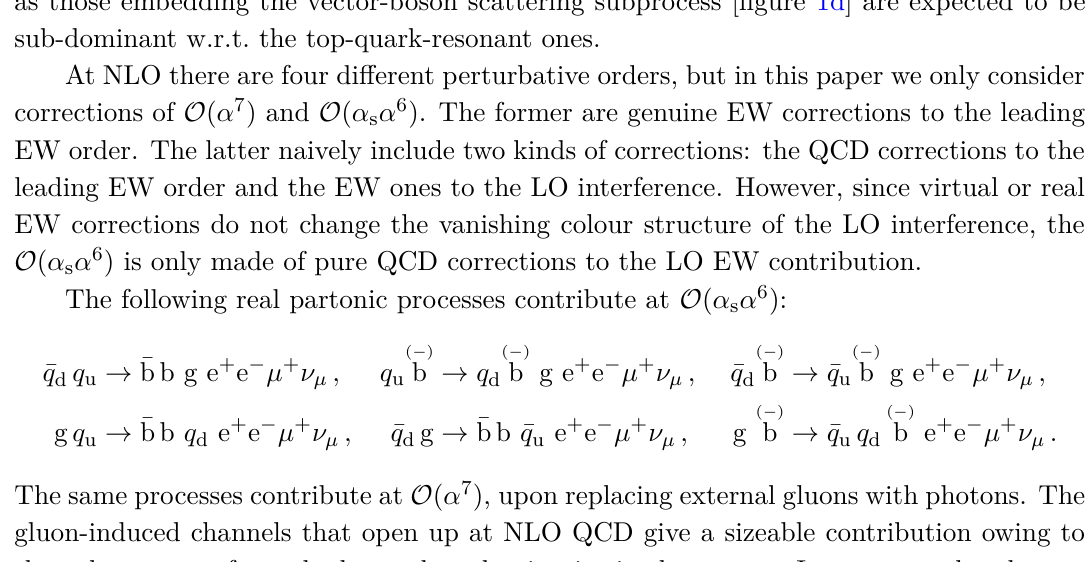
Figure 2. Sample diagram for anti-top-quark production in the g as those embedding the vector-boson scattering subprocess [figure 1d] are expected to be sub-dominant w.r.t. the top-quark-resonant